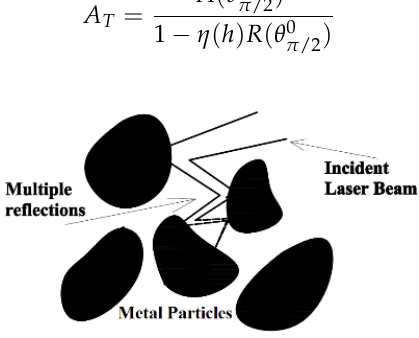
Figure 1. Illustration of the way in which the radiation reflected from a given particle may impact on the surrounding ones, in a multiple reflection process, resulting in a high absorption of the radiation supplied by the laser beam.